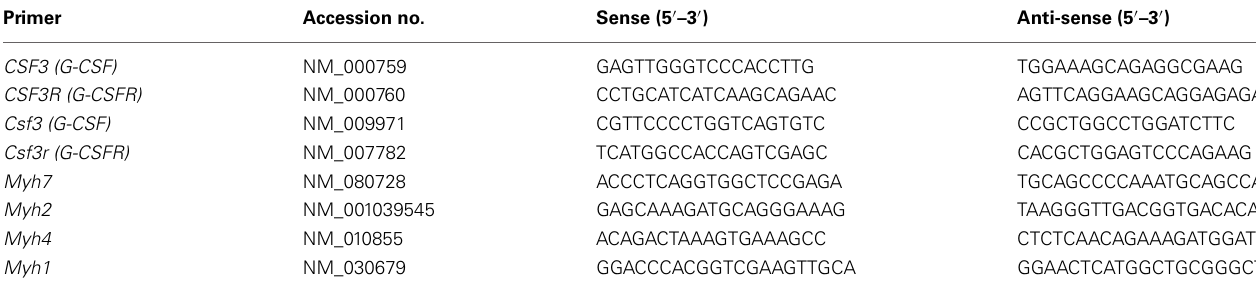
Table 1 | Human and mouse PCR primer